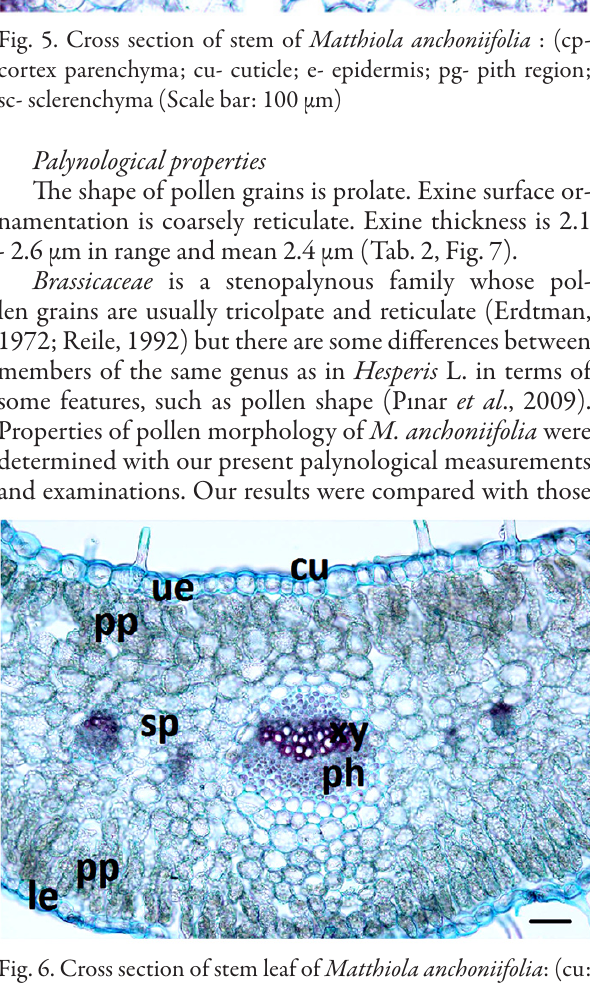
Fig. 4. Cross section of root of Matthiola anchoniifolia : (cp: cor- tex parenchyma; pd: periderm; ph: phloem; plg: root phello- gen; xy- xylem; xyp- xylem parenchyma (Scale bar=100 μm)